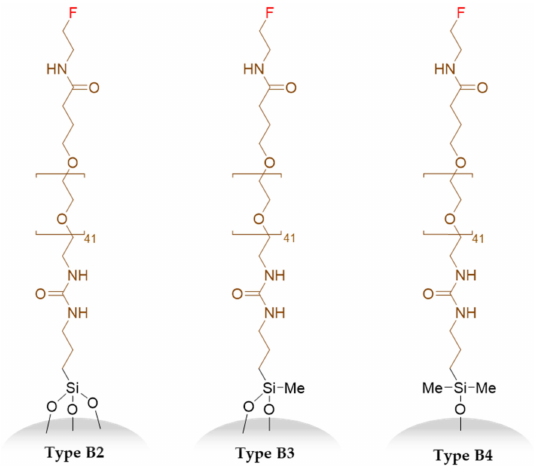
Figure 5. Fluorinated PEG particles ( B2 , B3 , and B4 ) bearing three, two, and one anchoring points,